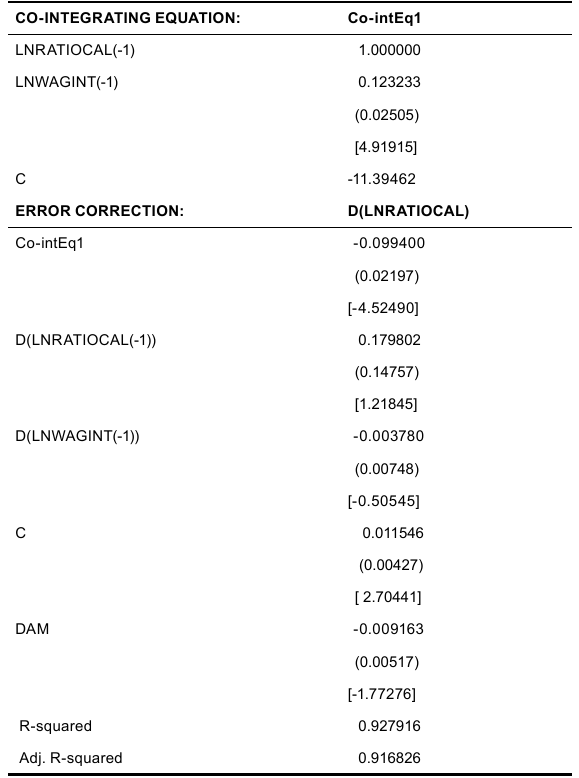
Error-correction form of the ration capital-labour, together with the co-integrating